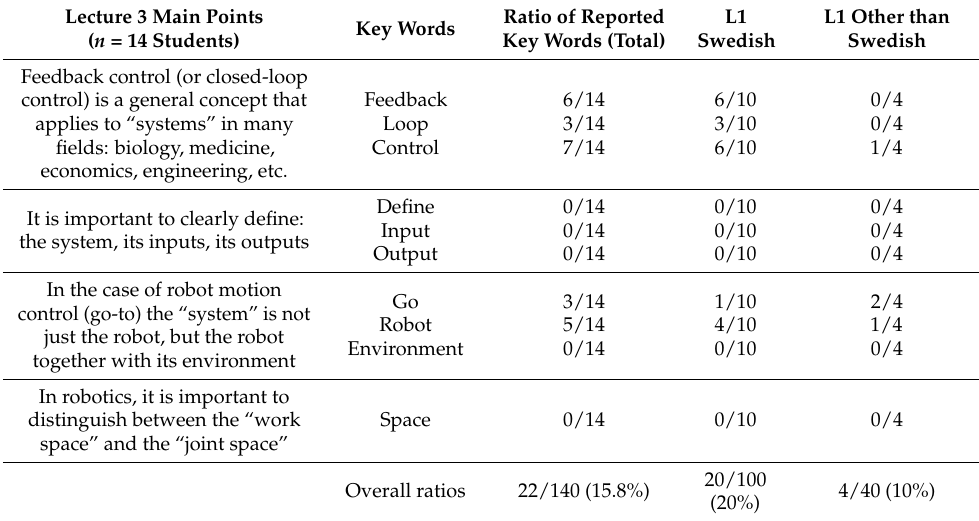
Table 4. Lecture 3 main idea key words